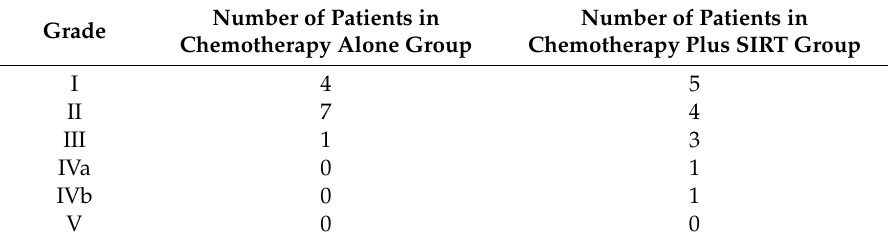
Table 3. Grading of surgical complications recorded in the FOXFIRE clinical trial. The table shows the grade for all patients who had complications post-hepatic resection using a classification developed for this indication [13]. Comparison of grades of complications between groups by Fisher’s exact test shows no significant difference between treatment groups ( p = 0.380). Grade